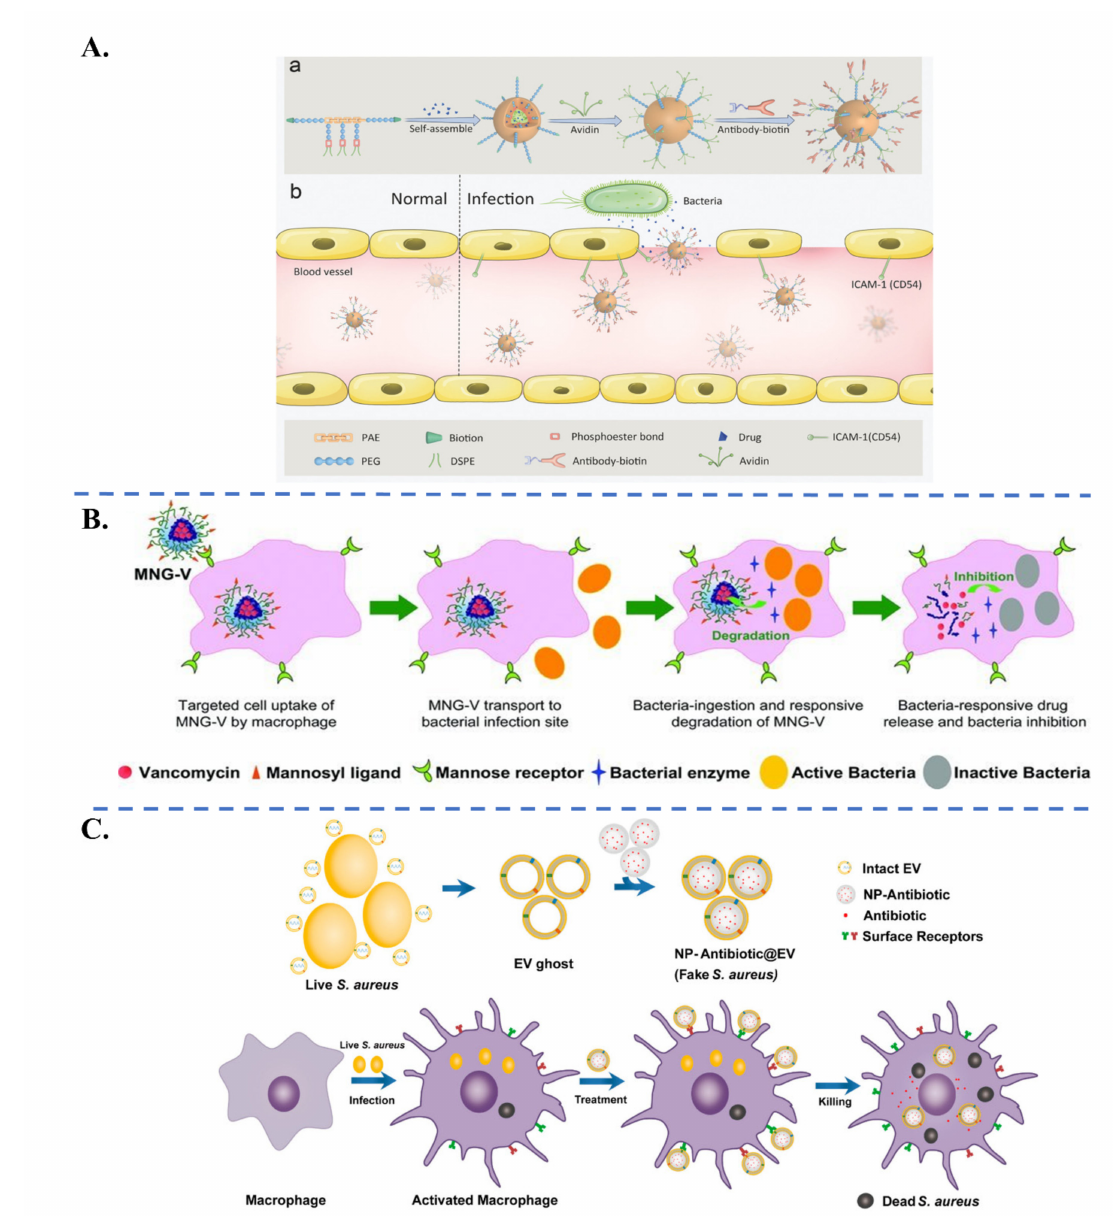
Figure 10. Active targeting of antibiotic-loaded nanocarriers to infectious microenvironment. ( A ) Schematic for the design of bioresponsive antibiotic-loaded NPs with a surface coating of ICAM-1 antibodies ( a ) and their action mechanisms ( b ). NPs specifically target activated endothelial cells at a site of infection after intravenous injection, then cross the blood vessel and release drugs triggered by the local infectious cues (pH/enzyme) (reprinted with permission from [55], copyright 2018 John Wiley and Sons). ( B ) Schematic illustration of the targeted uptake of mannosylated nanogels loaded with vancomycin (MNG-V) by macrophages and the responsive release of the antibiotic under the action of bacterial enzymes (reprinted with permission from [57], copyright 2012 John Wiley and Sons). ( C ) Schematic illustration on the preparation of NPs coated with the membrane of extracellular vesicle (EV) secreted by S. aureus as active-targeting antibiotic carrier. Because the nanocarrier is camouflaged with the membrane of S. aureus EV, S. aureus -infected macrophages may mistake NPs as S. aureus , leading to promoted NP internalization and, consequently, facilitated intracellular delivery of its drug cargoes (reprinted with permission from [116], copyright 2019